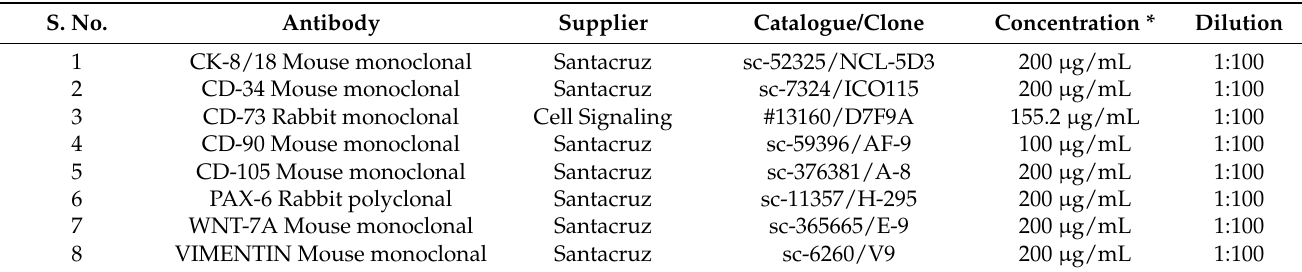
Table 1. List of primary antibodies used in immunofluorescence.